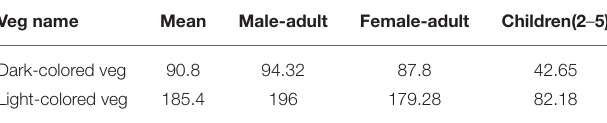
TABLE 1 | Vegetable consumption (g/d) (East China, China, 2013).